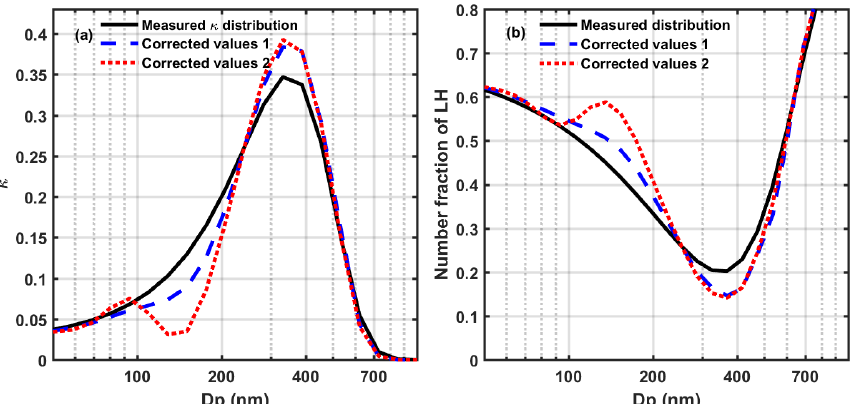
Figure 5. (a) Multi-charge correction of a hypothetical measured κ distribution. The black line is the measured size-resolved κ , and the dashed lines are multi-charge-corrected κ distributions based on different number size distributions. The PNSDs used are shown in Fig. 1. (b) Multi-charge correction for a mixing state distribution. The black line represents the measured size-resolved number fraction of LH particles, and the dashed lines are the multi-charge-corrected values based on different number size distributions.